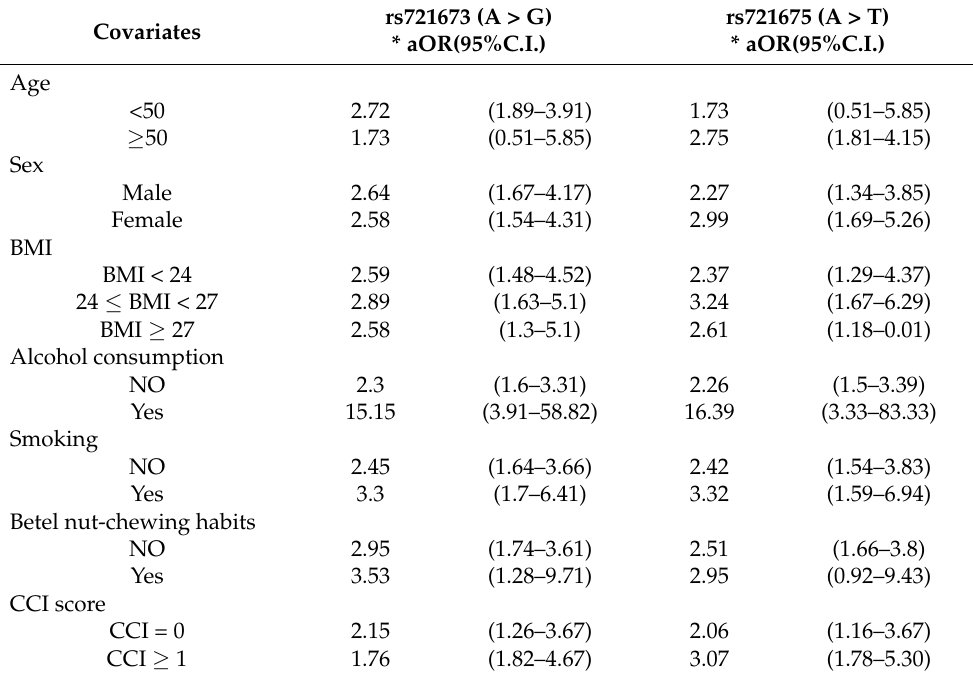
Figure 1. ( A ) Kaplan–Meier estimates of the cumulative incidence rate of CRC with HSD17B4 rs721673 risk genotype and wild genotype groups. ( B ) Kaplan–Meier estimates of the cumulative incidence rate of CRC with HSD17B4 rs721675 risk genotype and wild genotype groups. Table 2. Multivariate logistic regression analysis for the association between HSD17B4 rs721673 and rs721675 and the risk of colorectal cancer (CRC) based on sex, age, and BMI groups.